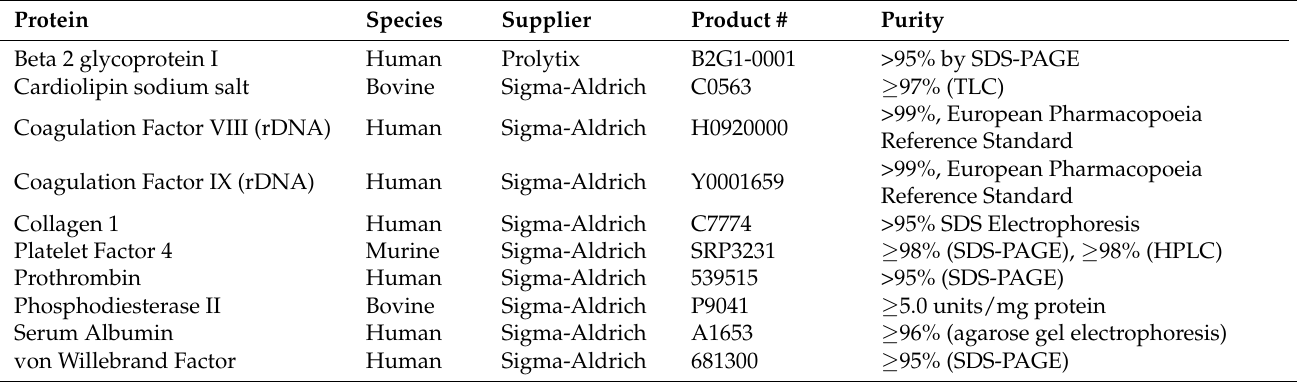
Table 4. Proteins used in this